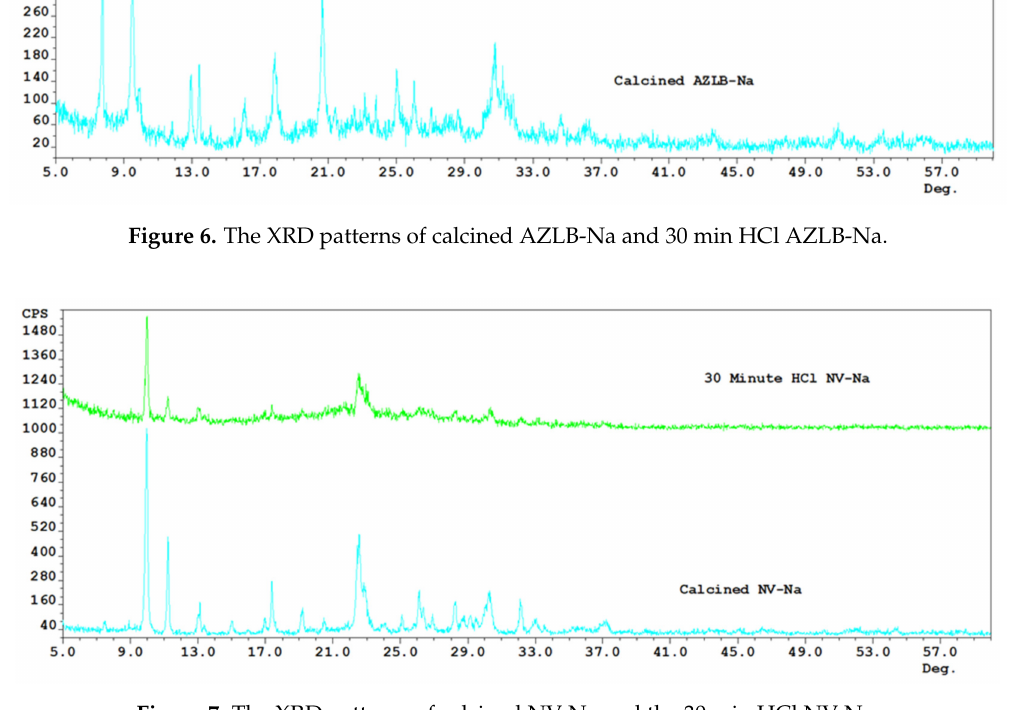
Figure 7. The XRD patterns of calcined NV-Na and the 30 min HCl